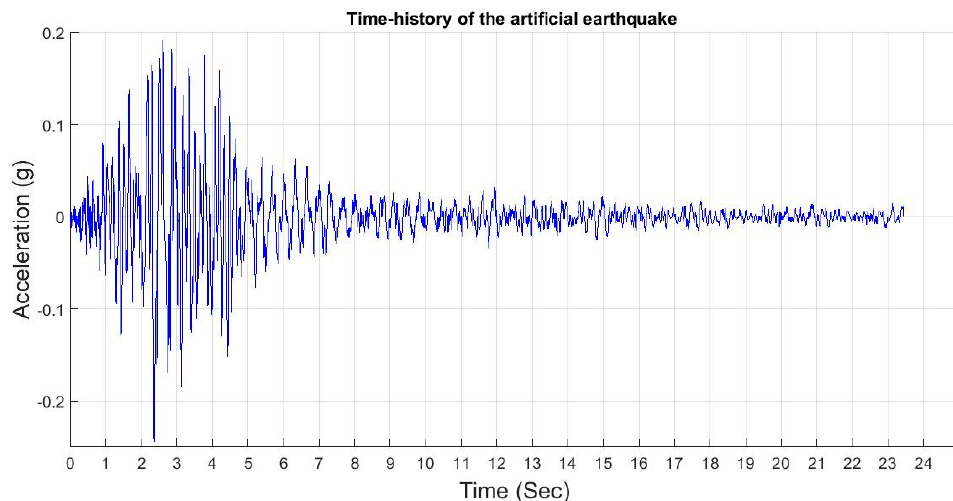
Figure 2. Time history of the artificial earthquake.